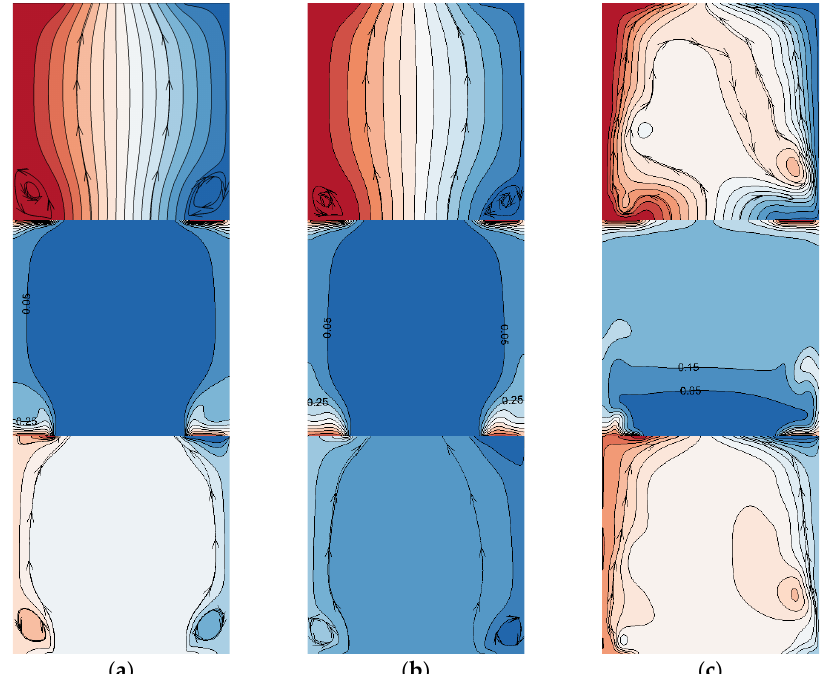
Figure 12. Contours of streamlines, isotherms, and heatlines (from top to bottom) with an up-and- down arrangement of heat source (Type F). ( a ) Ri = 0.01, ( b ) Ri = 0.4, and ( c ) Ri = 100. Figure 11 shows the contours of streamlines, isotherms, and heatlines for Type E, with two symmetric heat sources attached to the left and right inner walls of the cavity. The global flow and the temperature field are symmetric. Similar to Type D, for low Ri , e.g., Ri = 0.1 and Ri = 4, the gaseous waste flows through the cavity; only the region near the heat source is heated. Some heat is transferred from the heat source to the bottom